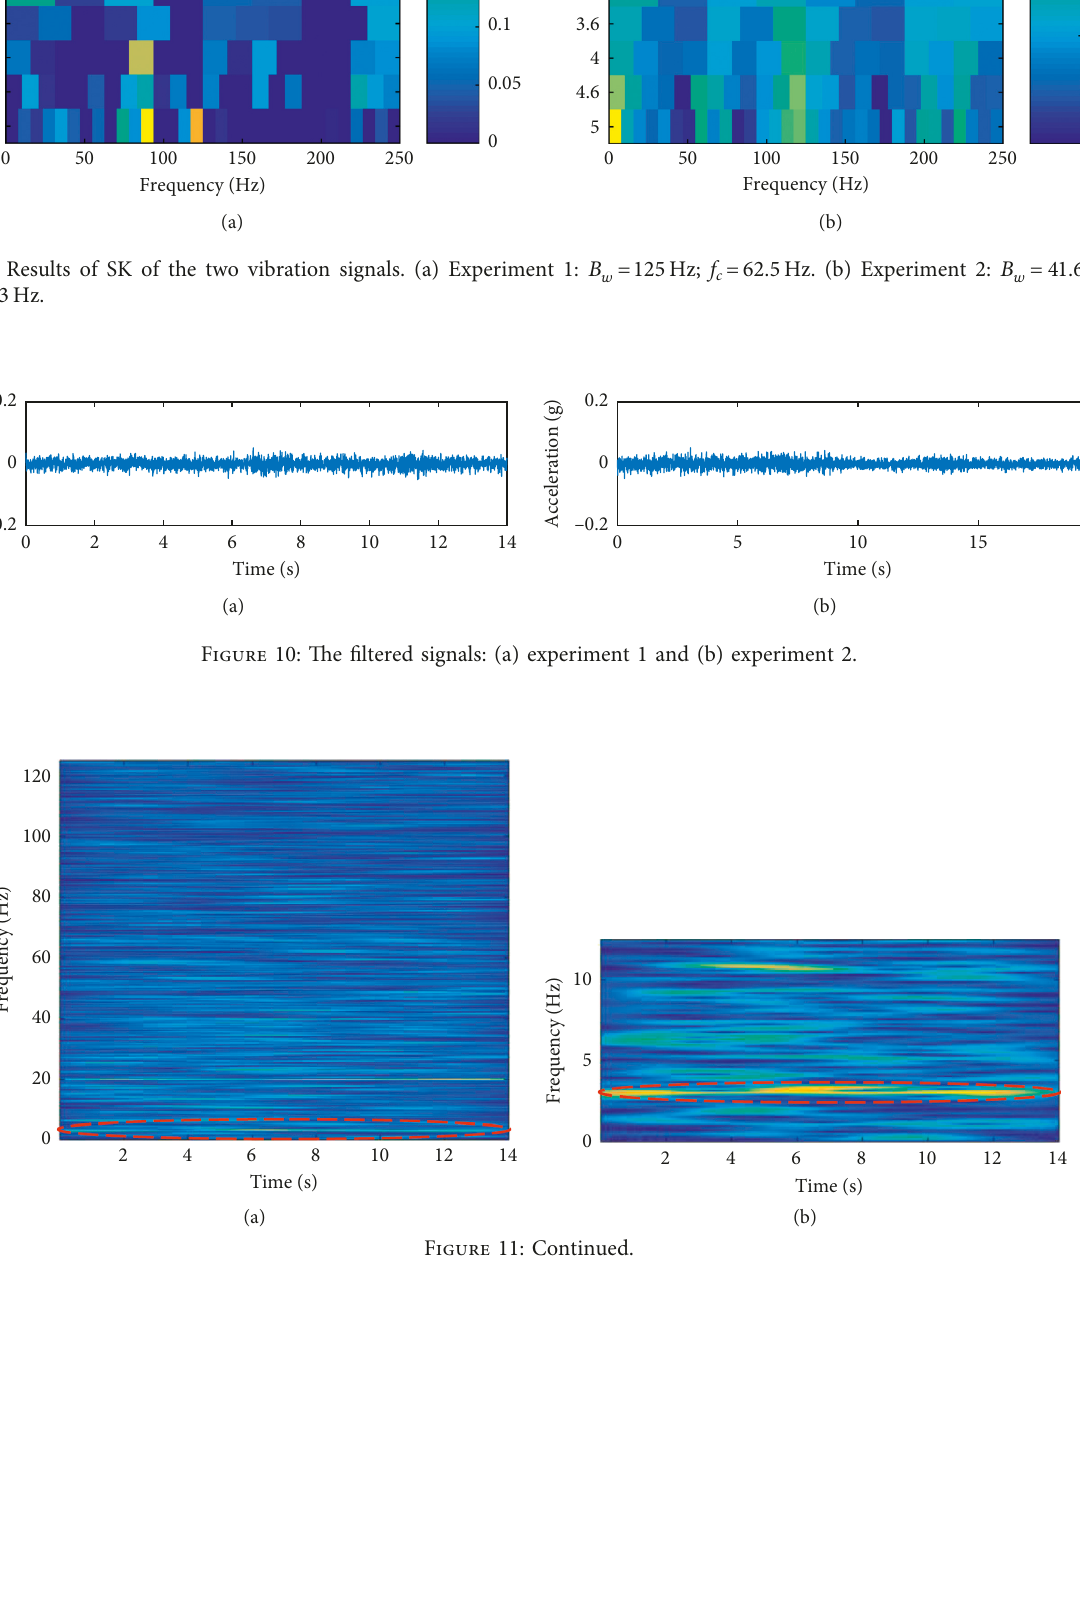
w (cid:31) 125Hz; f c (cid:31) 62.5Hz. (b) Experiment 2: